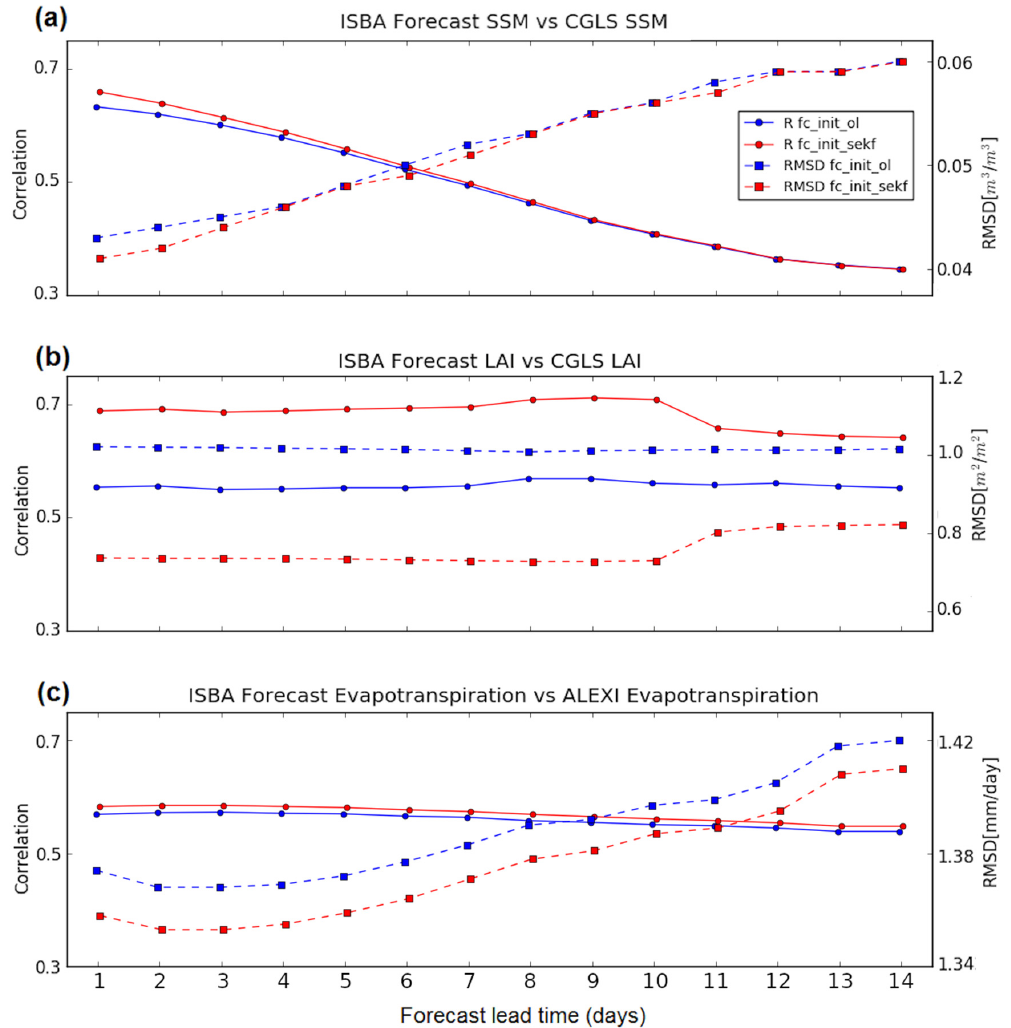
Figure 6. Correlations (solid lines, circles) and RMSD (dashed lines, squares) given for the variables of ( a ) SSM, ( b ) LAI, and ( c ) ET. Both statistics are presented for both OL (blue) and SEKF (red) initializations, and for each day of forecast lead time.